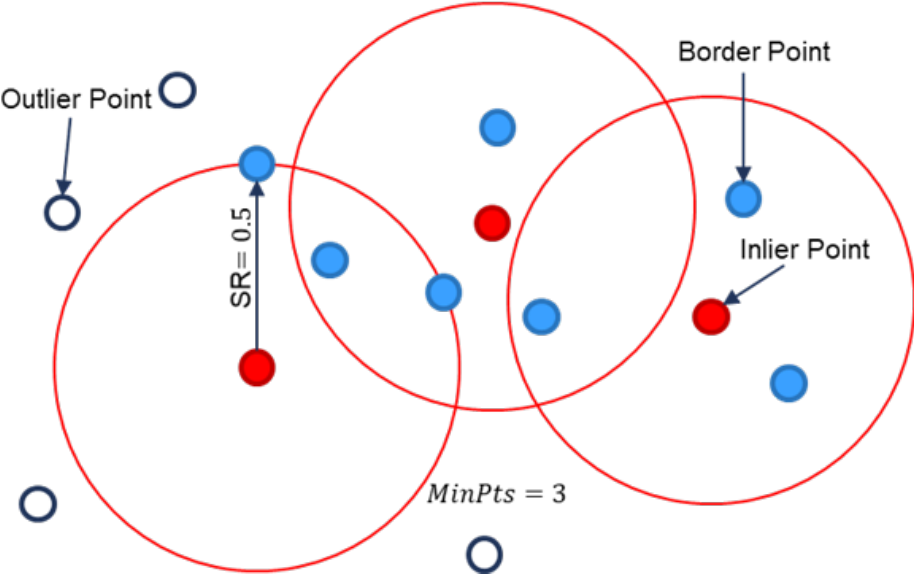
Figure 4. Adaptive Group of Density Outlier Removal algorithm example with a minimum number of neighbors of 3 and a search radius of